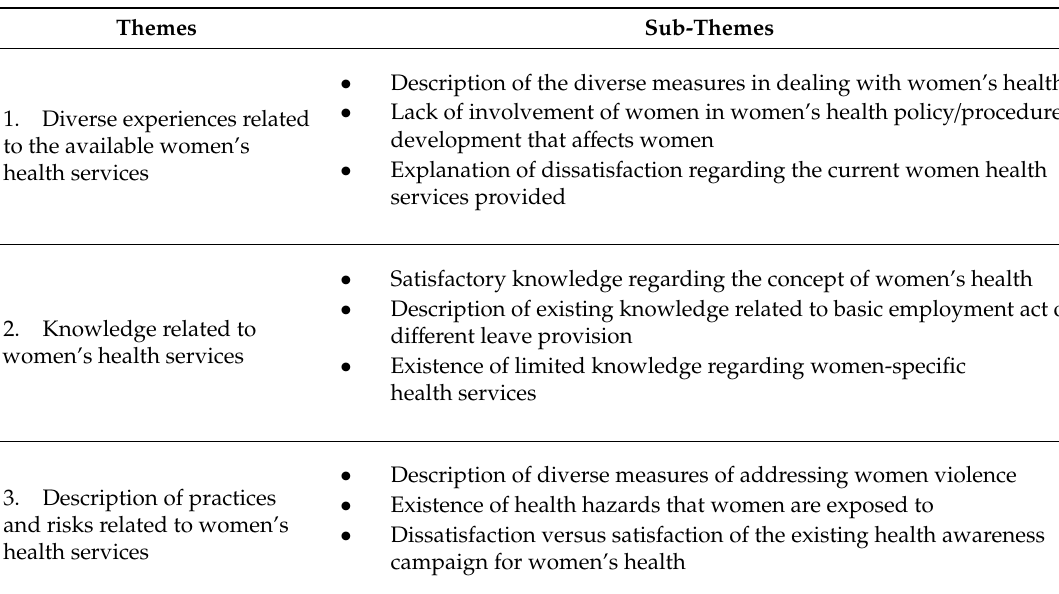
Table 4. Summary of the themes and sub-themes reflecting the experiences of women related to comprehensive health services for women at the